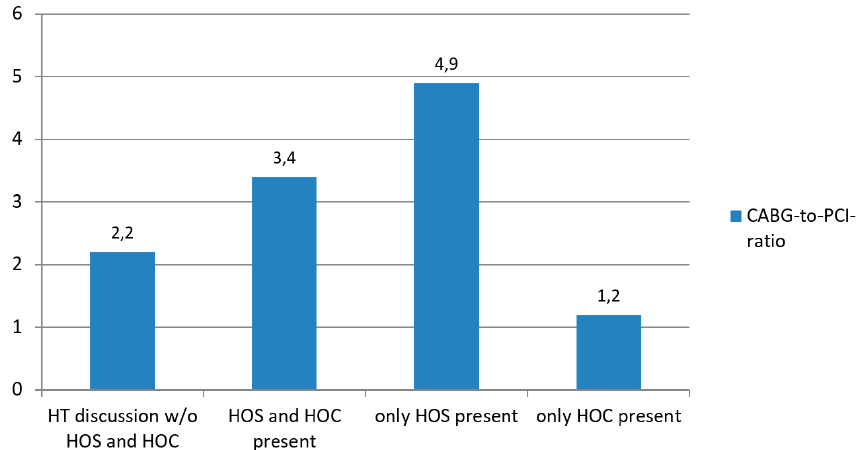
Figure 2. Heart Team decisions in relation to the absence or presence of the directors of the department of cardiovascular surgery or the department of interventional cardiology. Legend: Bar chart of CABG-to-PCI ratio. HOC = Head of Cardiology; HOS = Head of Cardiac Surgery; HT = Heart Team; CABG = coronary artery bypass grafting; PCI = percutaneous coronary intervention; w/o = without.